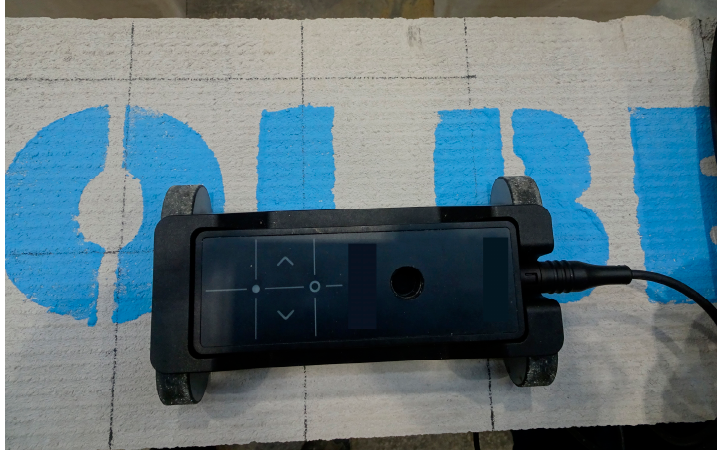
Figure 10. Transducer on the surface of the tested element.